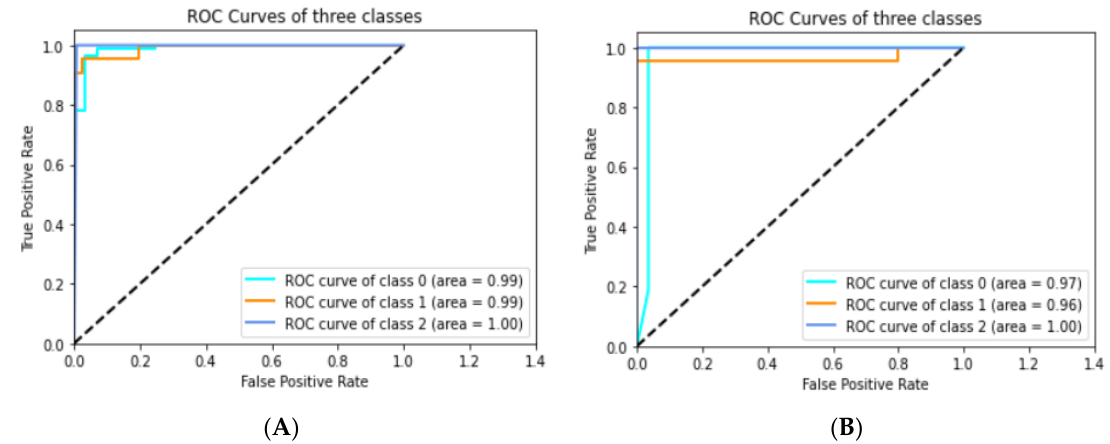
Figure 8. The ROC curve of three classes after 25% test split. ( A ) Customized CNN with Adam optimizer and a learning rate of 0.001. ( B ) Customized CNN with RMSprop optimizer and a learning rate of 0.001.